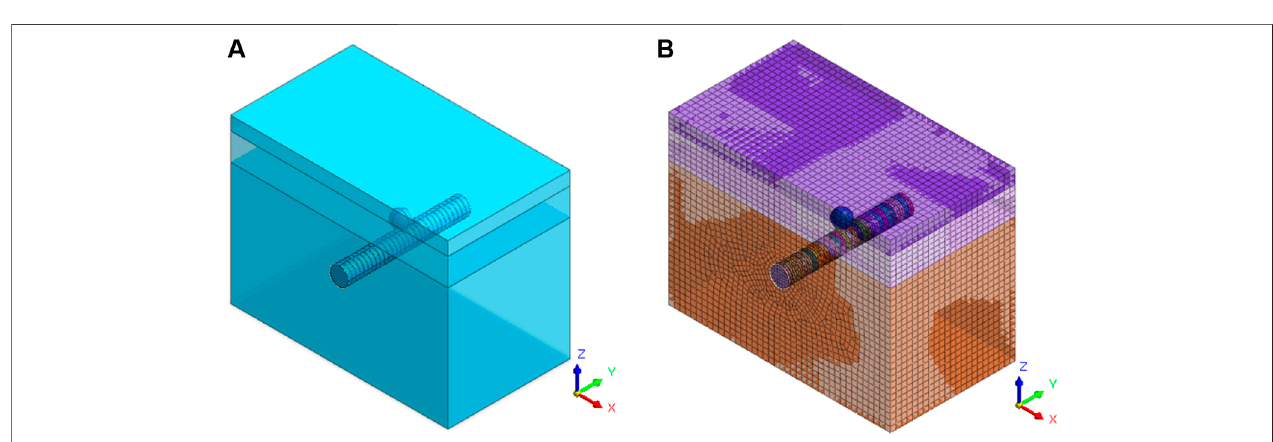
FIGURE 10 | Numerical simulation of the tunnel crossing the boulder stratum. (A) Geometric model of the tunnel crossing the solitary formation. (B) Grid model diagram of the tunnel crossing the solitary stone formation.